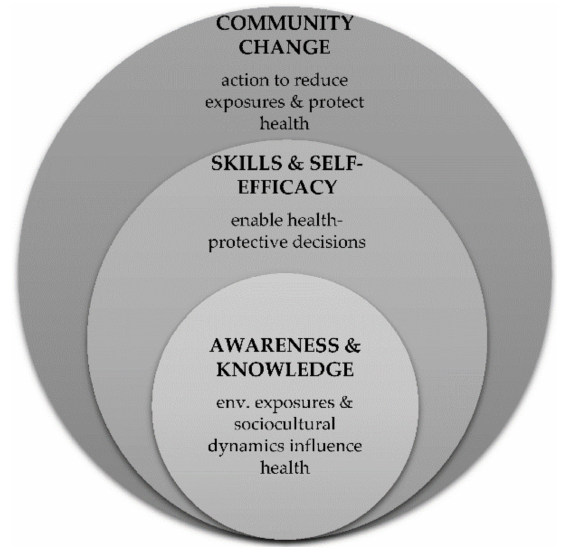
Figure 1. Three dimensions of environmental health literacy (EHL), as proposed by Gray